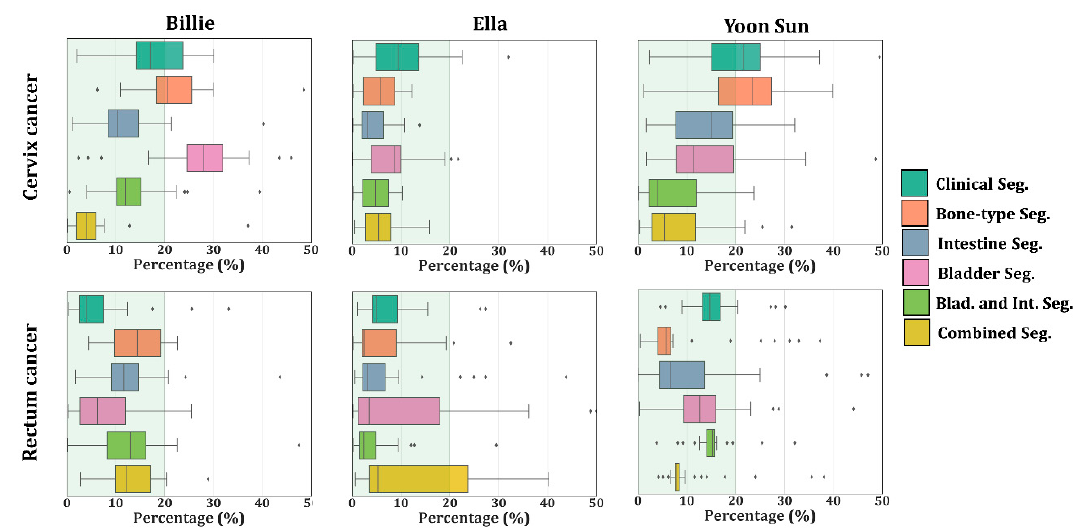
Figure 5. Boxplot with the maximum |dRD| in the female models. |dRD| was normalized to the maximum SAR for each tissue in the benchmark and expressed as a percentage (%). The inter-quartile range represents the middle 50% of the dataset, where the right box line represents 75% of the dataset that falls below the upper quartile, the left line represents 25% of the dataset that falls below the lower quartile, and finally, the middle line represents the median. The line extending from the box represents 2.5% and 97.5% limits of the dataset.